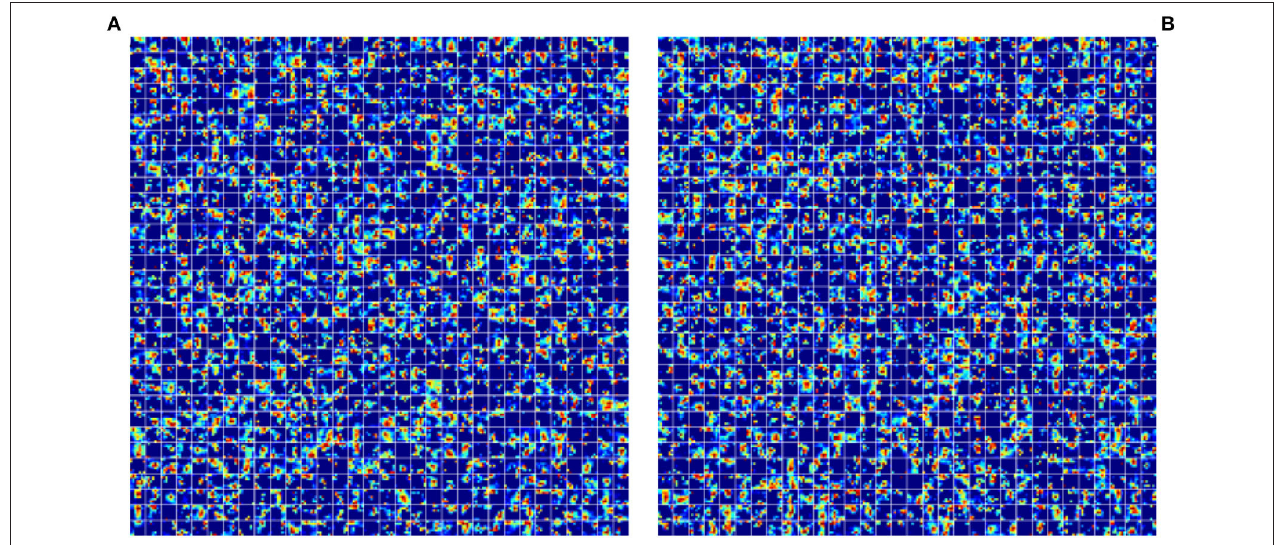
FIGURE 11 | Illustration of noise mask generated by different GAN models. (A) Feature maps generated by WGAN. (B) Feature maps generated by SAGAN.